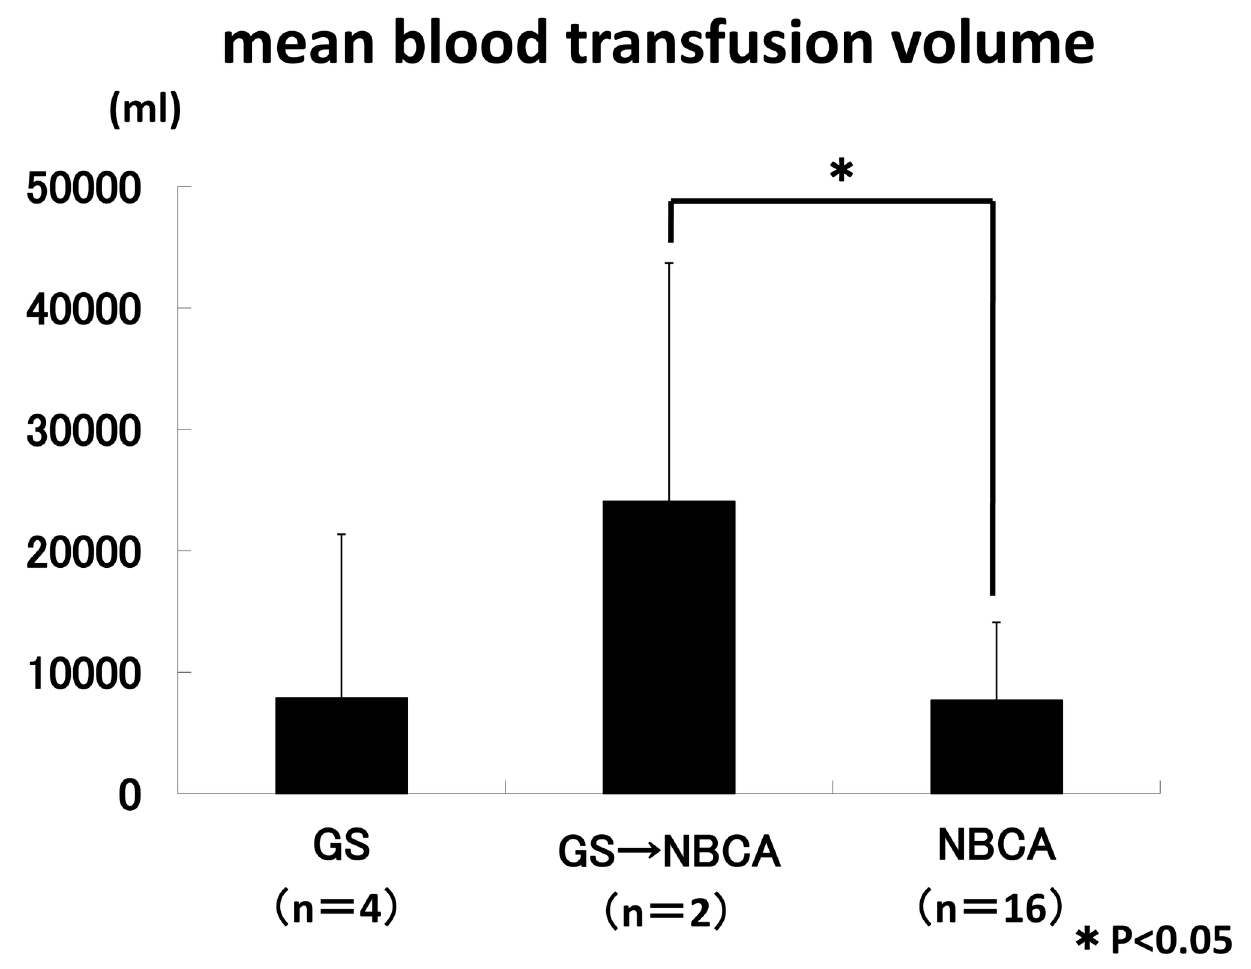
Figure 2. The mean blood transfusion volume was 7,885.0±13,491.2 mL, 24,065.0±19,622.2 mL, and 7,677.8±6,434.0 mL, respectively. A significant difference was seen between combined GS and NBCA and NBCA only (P<0.05). doi: